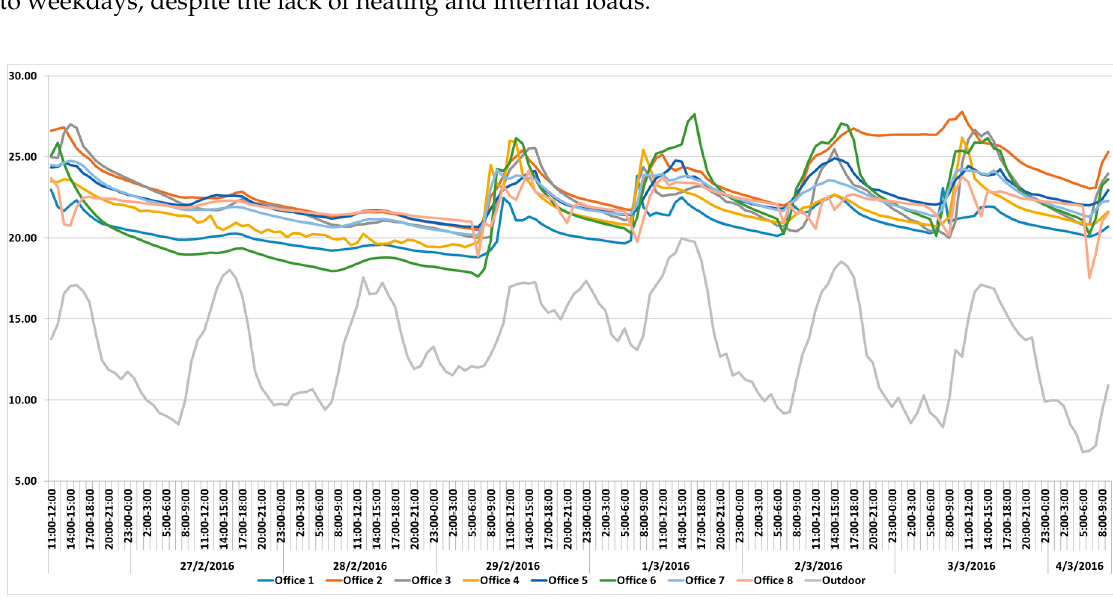
Figure 5. Temperature levels of the external and all the indoor environment of Building B during summer.